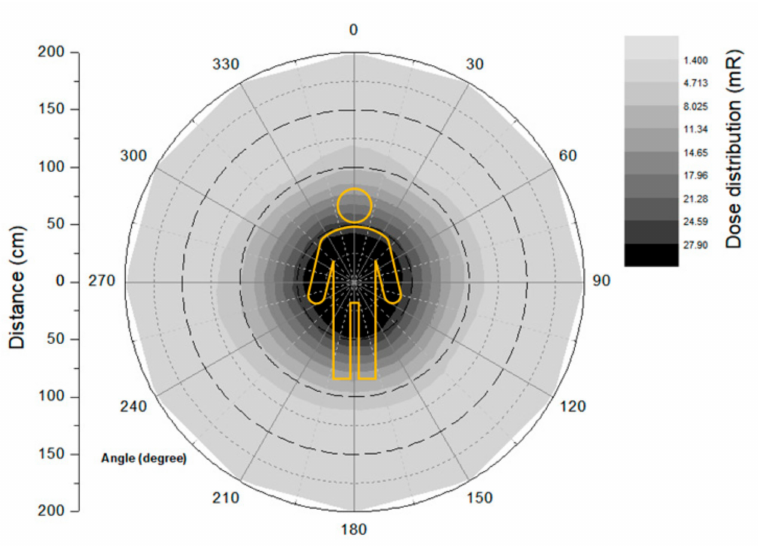
Figure 8. Spatial dose distribution inside the imaging room of a medical